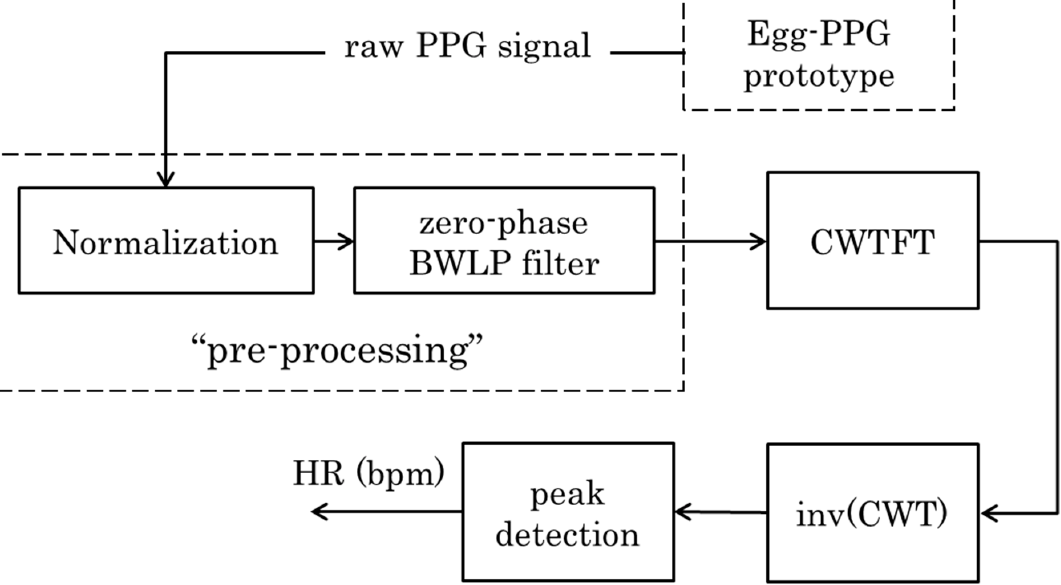
Figure 3. Block diagram showing the main signal processing steps to extract the embryonic heart rate using the Egg-PPG prototype. The block diagram includes the pre-processing, continuous wavelet transform Fourier transform ( CWTFT ) algorithm, inverse continuous wavelet transform ( invCWT ), and peak detection algorithm blocks.